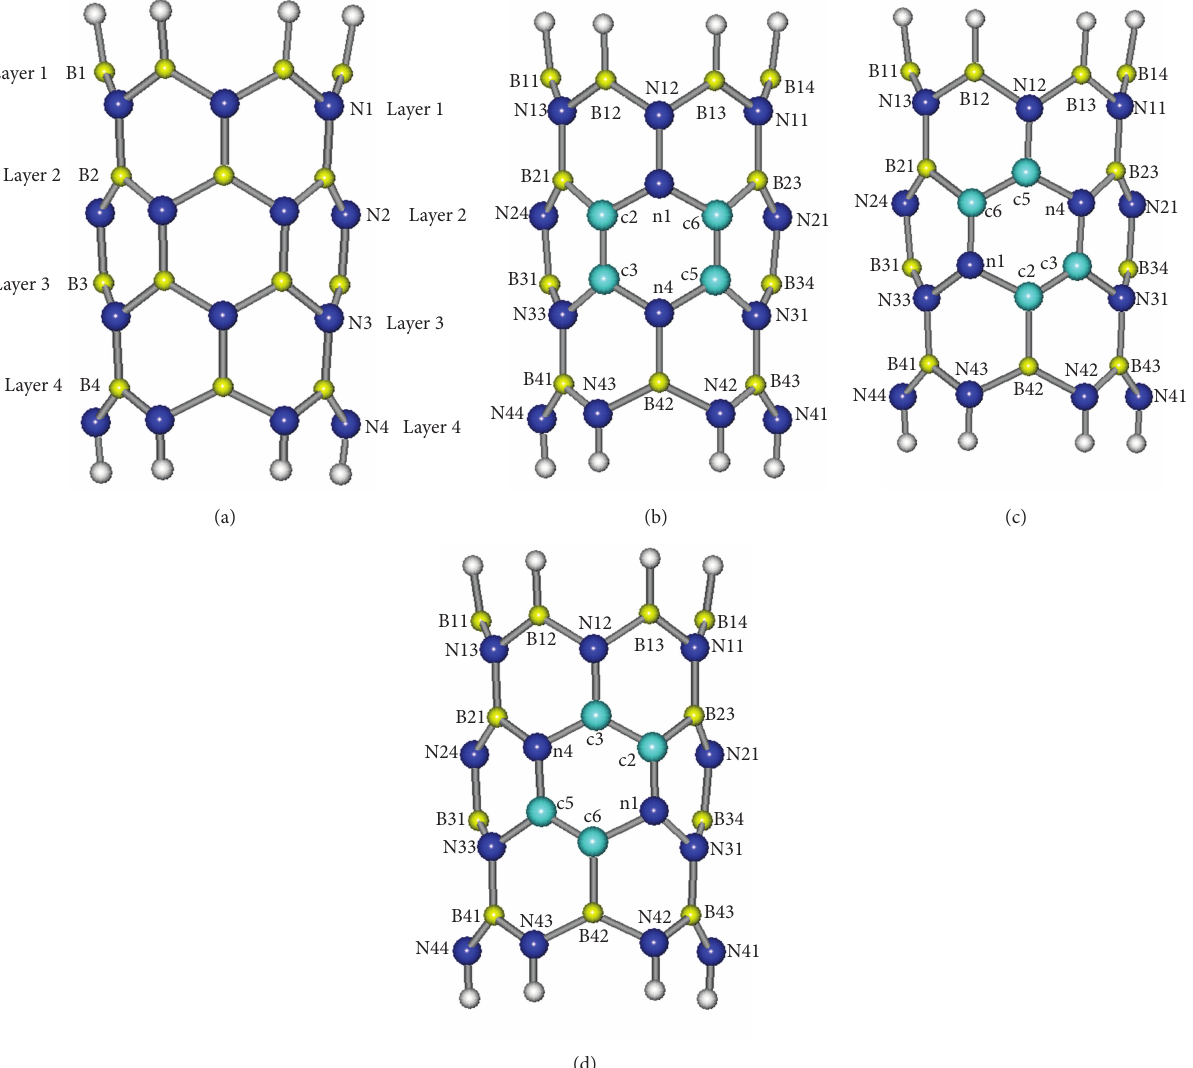
F 1: e front side view of perfect BNNTs model (a) and pyrazine-doped BNNTs models